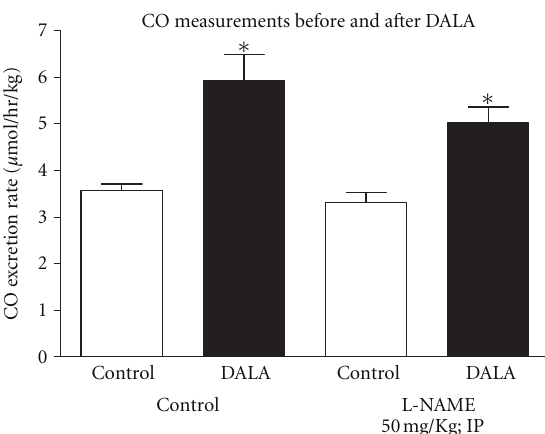
Figure 1: DALA (80 μ mol/kg; IV) infusion acutely increased expired CO levels in L-NAME-treated and -untreated awake rats. Values are mean ± SE; n = 6 each.